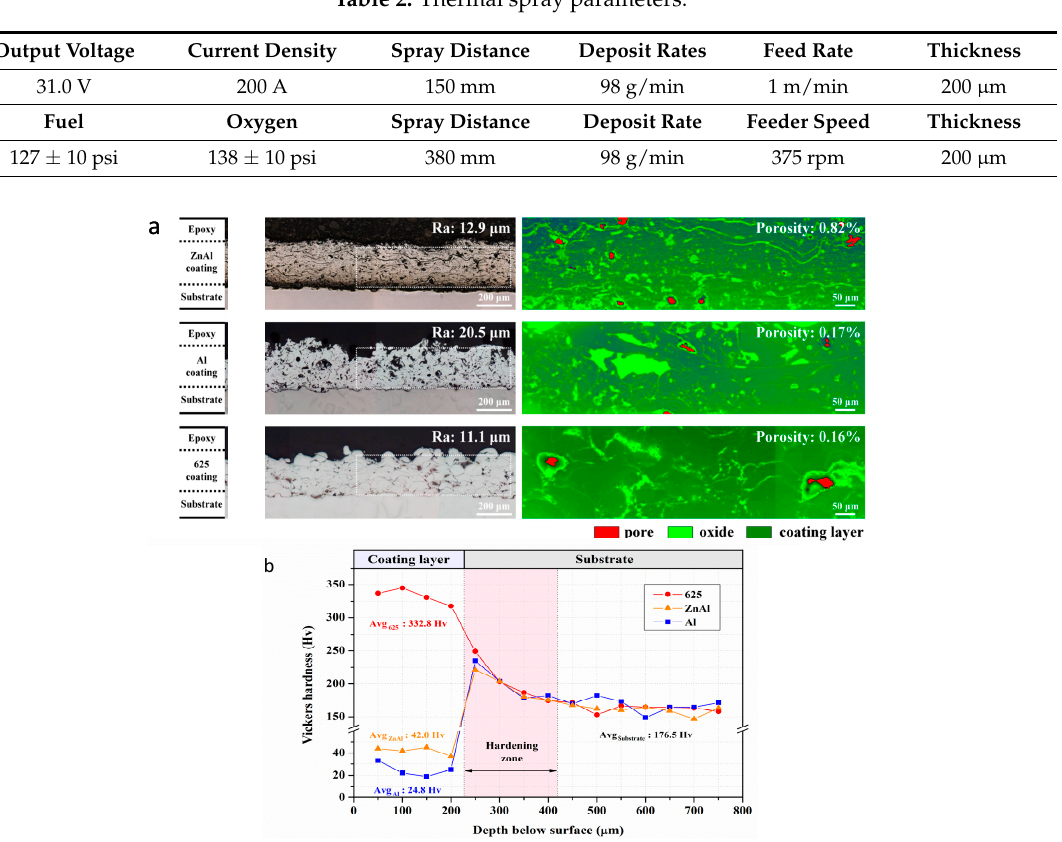
Figure 1. ( a ) Cross-section optical images of the three coatings, Al, ZnAl and Inconel 625 and ( b ) the cross-sectional hardness test for the three coatings on SS304L.